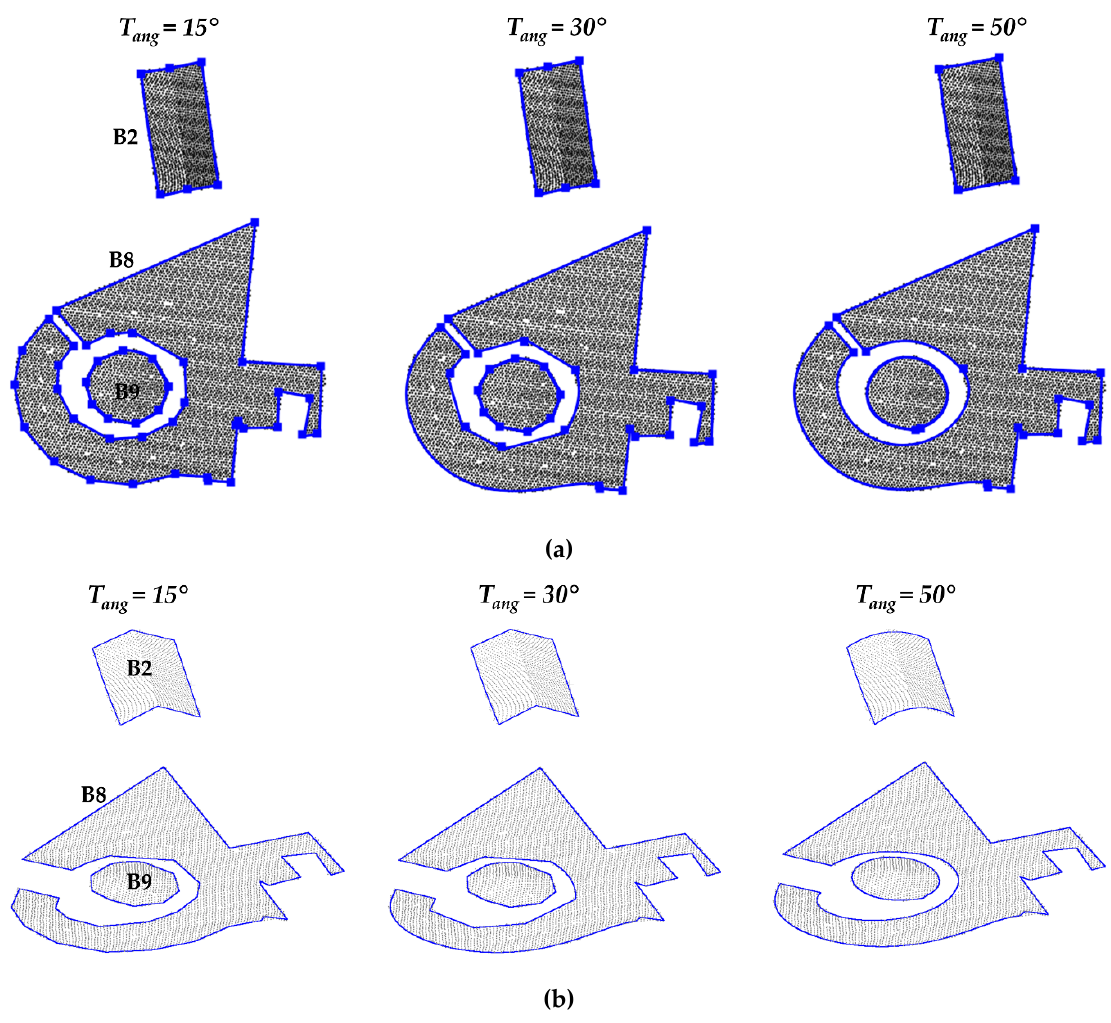
Figure 10. Results using different T ang values for buildings B2, B8, and B9. Representation of regularized boundaries and corner points in bidimensional space ( a ), and regularized boundaries in tridimensional space ( b ).